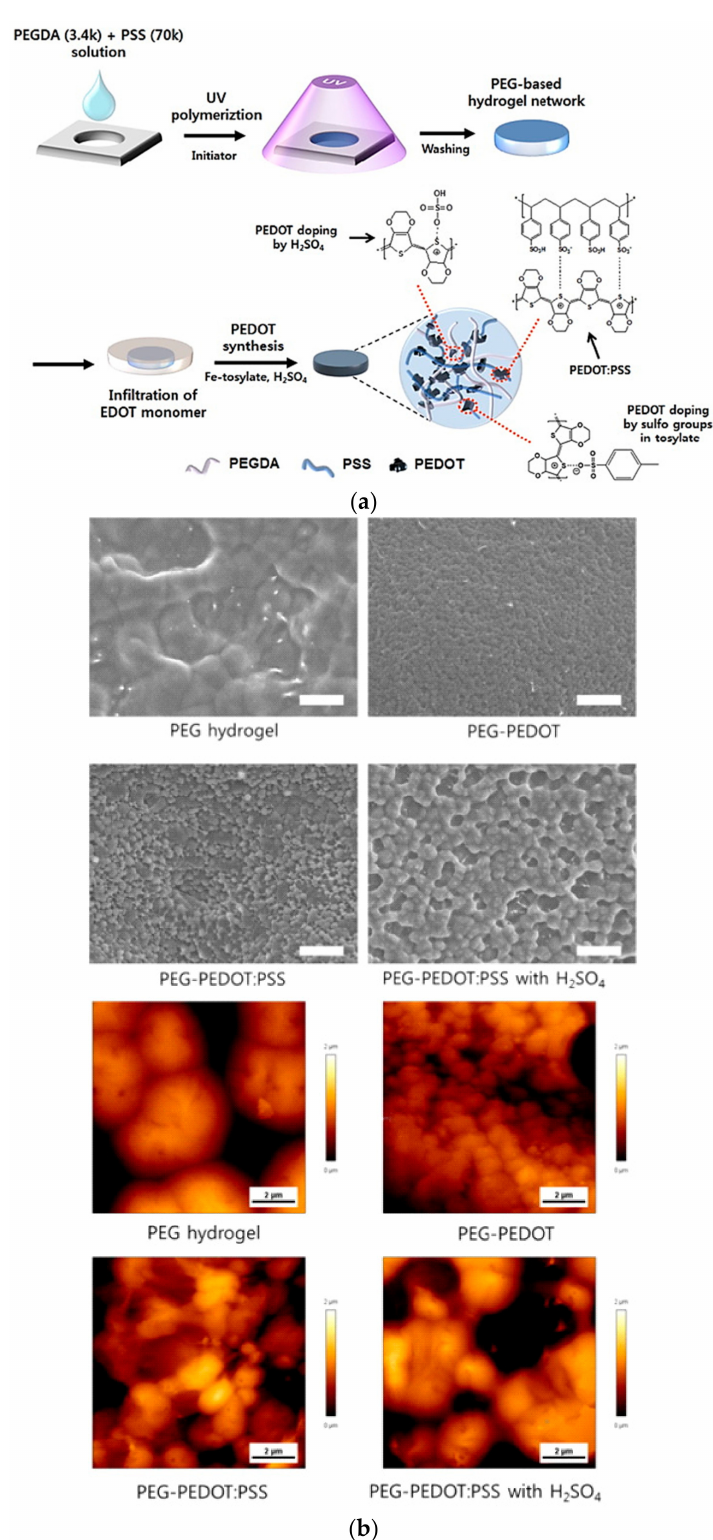
Figure 11. Conductive PEDOT-PEGDA hydrogels using PSS-PEDOT ( a ) scheme of synthesizing conductive hydrogels and ( b ) surface morphology of PEG hydrogel, PEG-PEDOT, PEG-PEDOT:PSS, and PEG- PEDOT:PSS treated with H 2 SO 4 (reproduced from [148] with permission, copyright Elsevier,